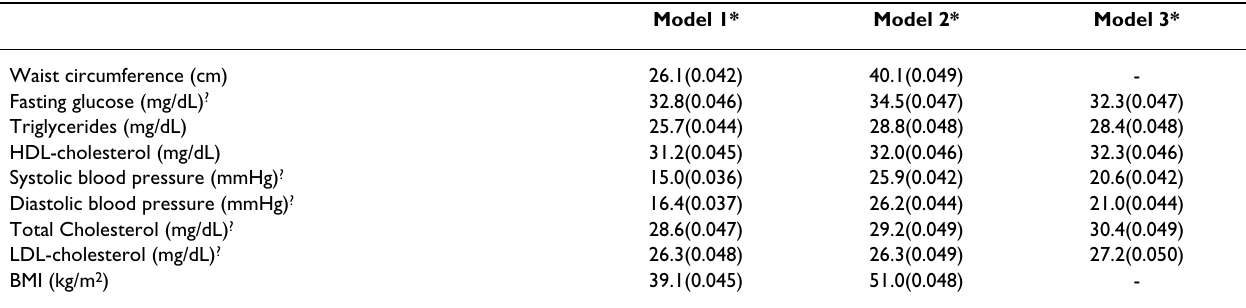
Table 2: Heritability (h2) estimates, and standard error, for each quantitative trait for cardiovascular risk factors (in percentage), unadjusted (Model 1), adjusted for age, sex, age2, and age × sex interaction (Model 2), and adjusted for age, sex, age2, and age × sex interaction, and current medication (Model 3).